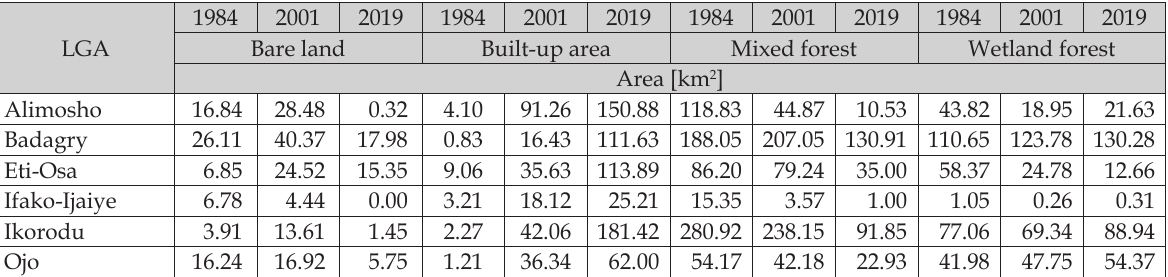
Table 2. Areal changes in land cover within the six focus LGAs between 1984 and 2019.